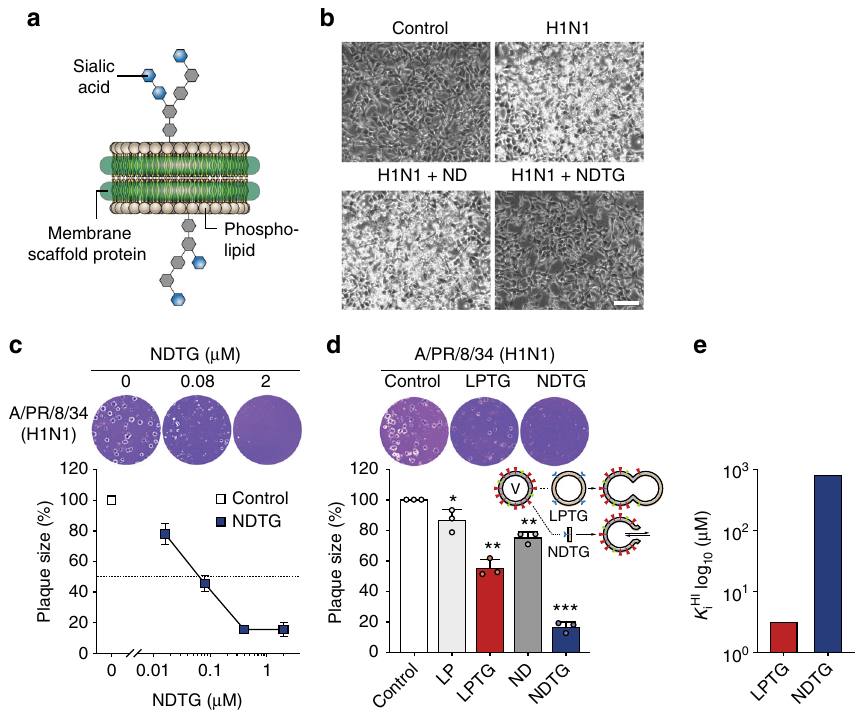
Fig. 1 In vitro inhibitory activity of NDTG against H1N1 virus infection. a Cartoon representation of the total ganglioside-embedded nanodisc (NDTG). b Microscopy observations of virus-induced CPE reduction in MDCK cells by NDTG. MDCK cells were either uninfected (control) or challenged with A/PR/ 8/34 H1N1 virus (MOI = 0.1) at 25 °C for 24 h, with 0.5 μ M ND or NDTG in the presence of TPCK-treated trypsin for activation of HA. CPE was observed at 24 h post-infection by inverted microscopy. Scale bar, 100 μ m. c , d Evaluation of antiviral activity of NDTG against H1N1 virus by a plaque reduction assay. MDCK cells were infected with ~100 PFU of H1N1. One hour after infection, the viral inoculum was removed, and cells were overlaid with agarose containing the indicated concentrations of NDTG ( c ), or overlay supplemented with ND, NDTG, LP or LPTG at the same lipid concentration of 50 μ M ( d ). Representative samples of viral plaques in each histogram are shown. Data are expressed as the mean ± standard deviation (SD) of triplicate samples. Error bars indicate SD, and asterisks indicate statistical signi fi cance determined by Student ’ s t -test (* P < 0.05; ** P < 0.01; *** P < 0.001). e Hemagglutinin inhibition by NDTG or LPTG. The lowest lipid concentration of inhibitor that completely suppressed hemagglutination was de fi ned as the